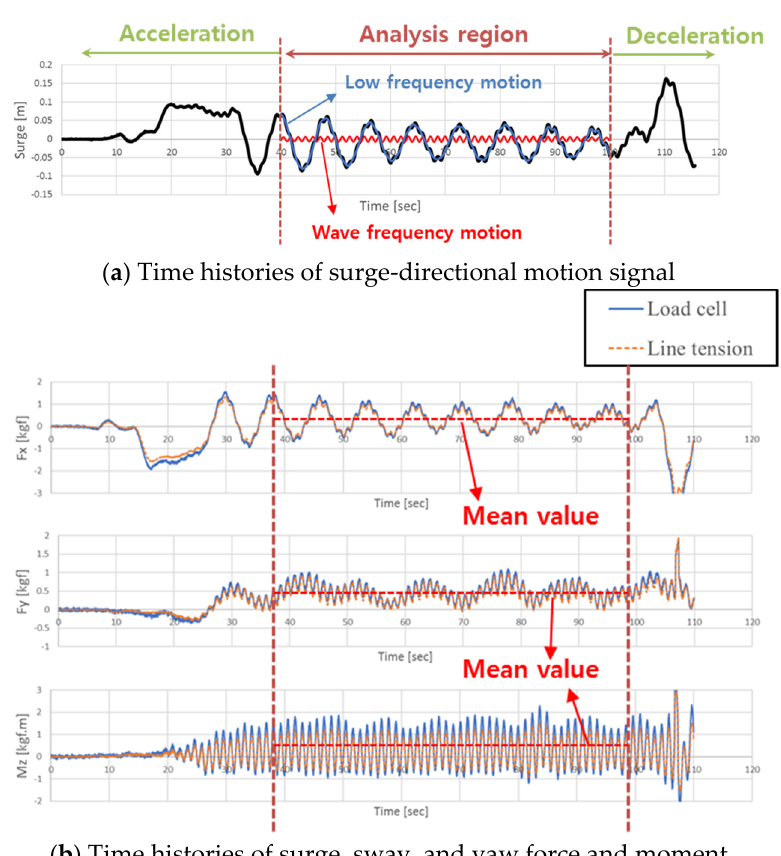
Figure 5. Examples of time histories.